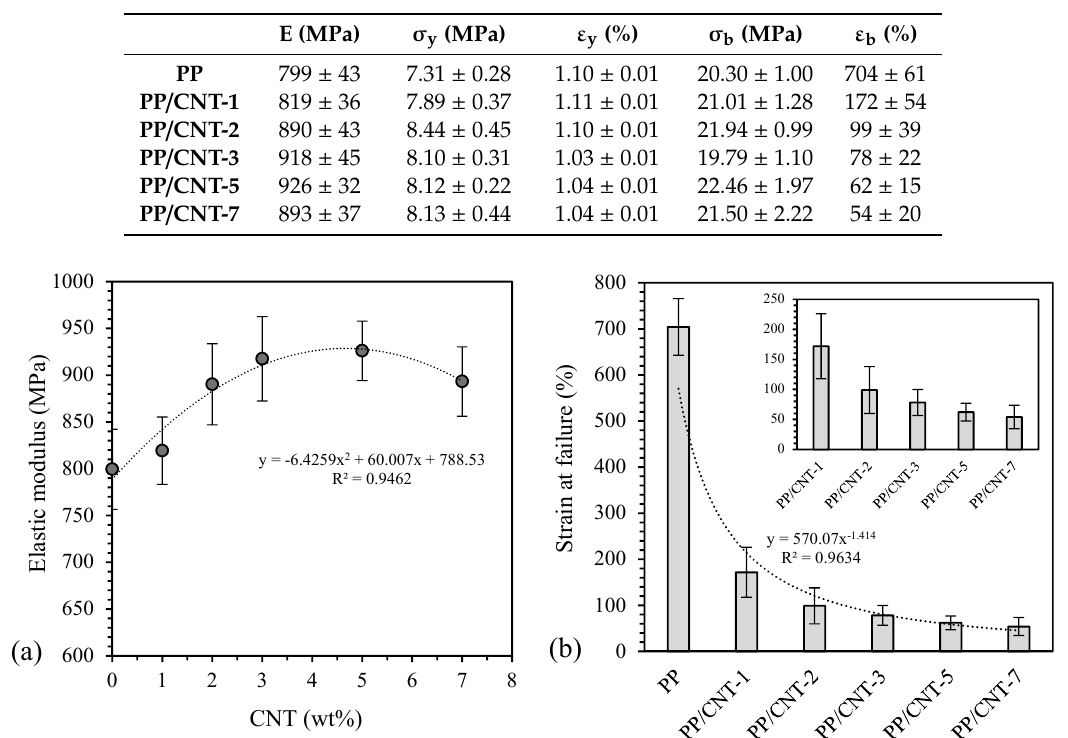
Table 4. Mechanical properties of PP and PP / CNT nanocomposites as determined via tensile tests (results are the average of ten measurements).